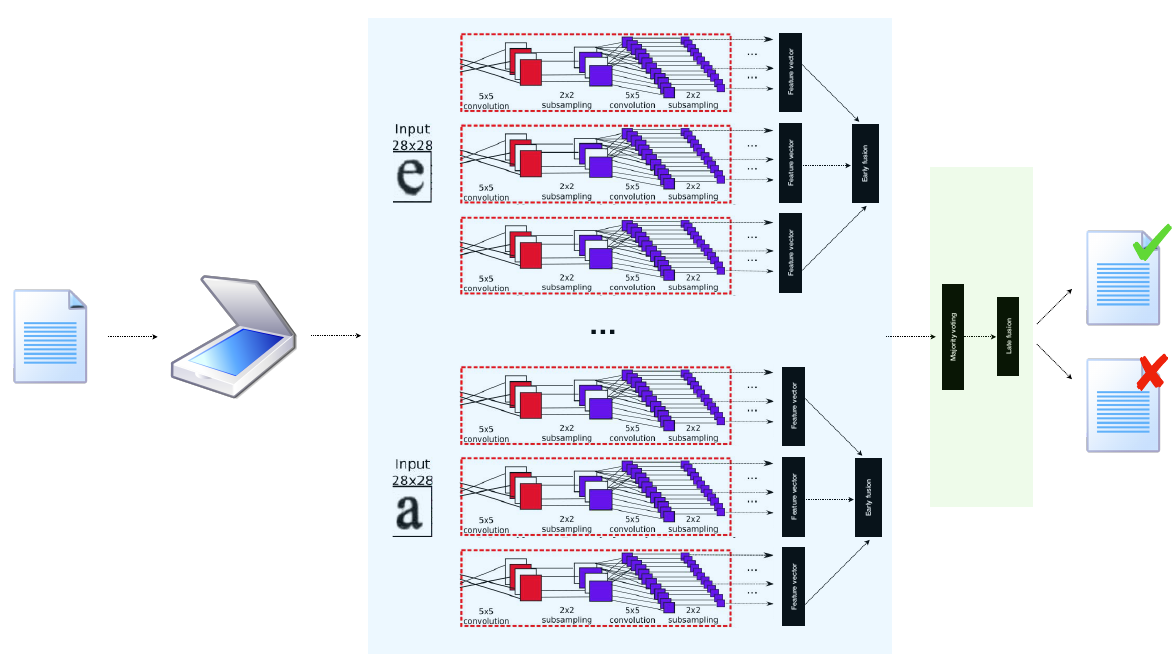
Fig. 8. Proposed multiple representations of different data for laser printer attribution through a set of lightweight Convolutional Neural Networks. Early and late fusion steps are highlighted in blue and green, respectively.